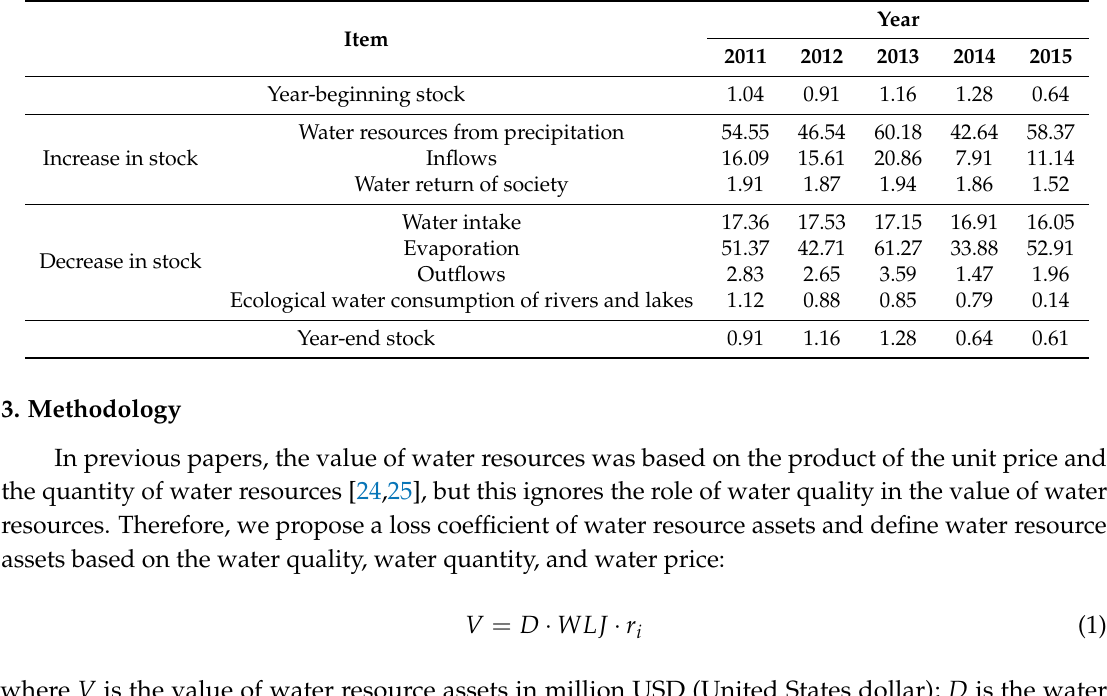
Table 1. Stock accounting of the water resources of Jinan City from 2011–2015 (100 million m 3 ).